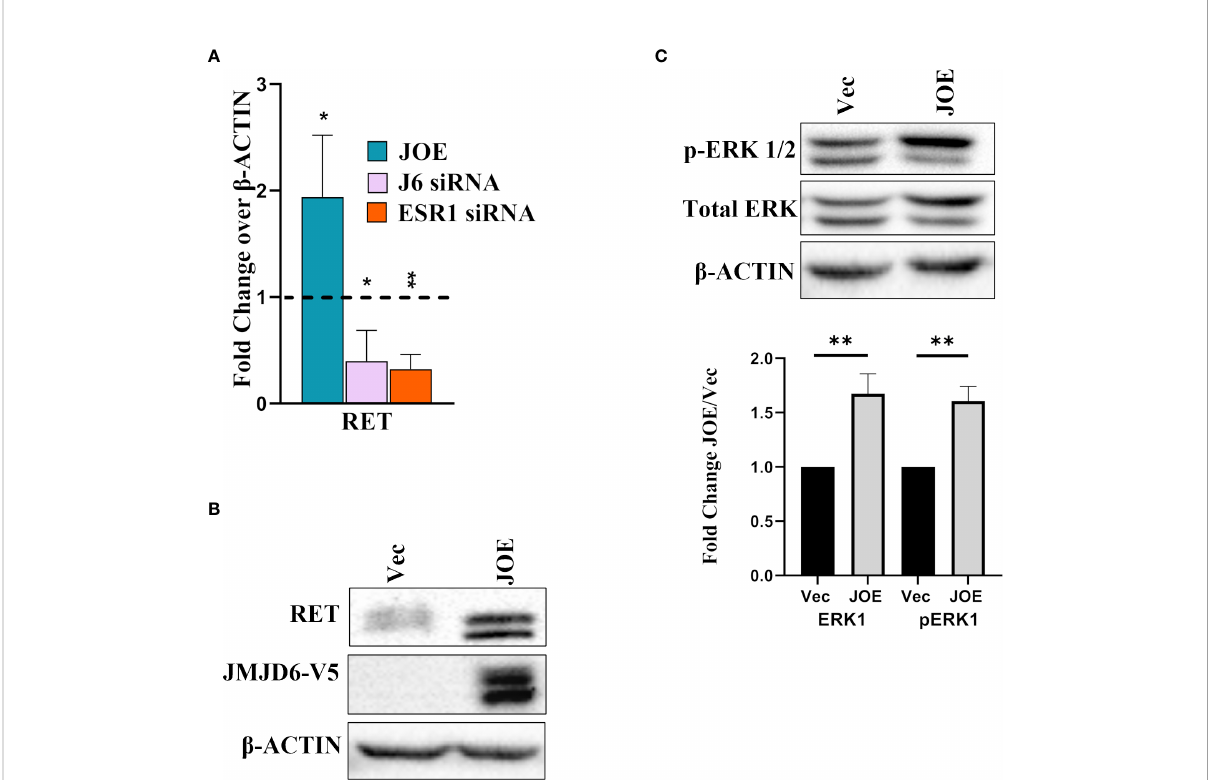
FIGURE 5 Effect of JMJD6 on known pathways in Tam insensitivity/resistance. (A) Western blot analysis of RET in Vec and JOE cells. (B) RET mRNA levels in JOE cells, J6 siRNA and ESR1 siRNA by qRT-PCR. Vector and Scrambled siRNA treated samples were used as respective controls and values were normalized to 1 (shown as a dotted line) (C) Western blot of total ERK 1/2 and p-ERK 1/2 in Vector and JOE cells. Lower Panel shows data obtained from densitometric scanning of ERK western blots. ERK expression levels in Vec cells were normalized to 1 and expression in JOE cells is shown as FC over